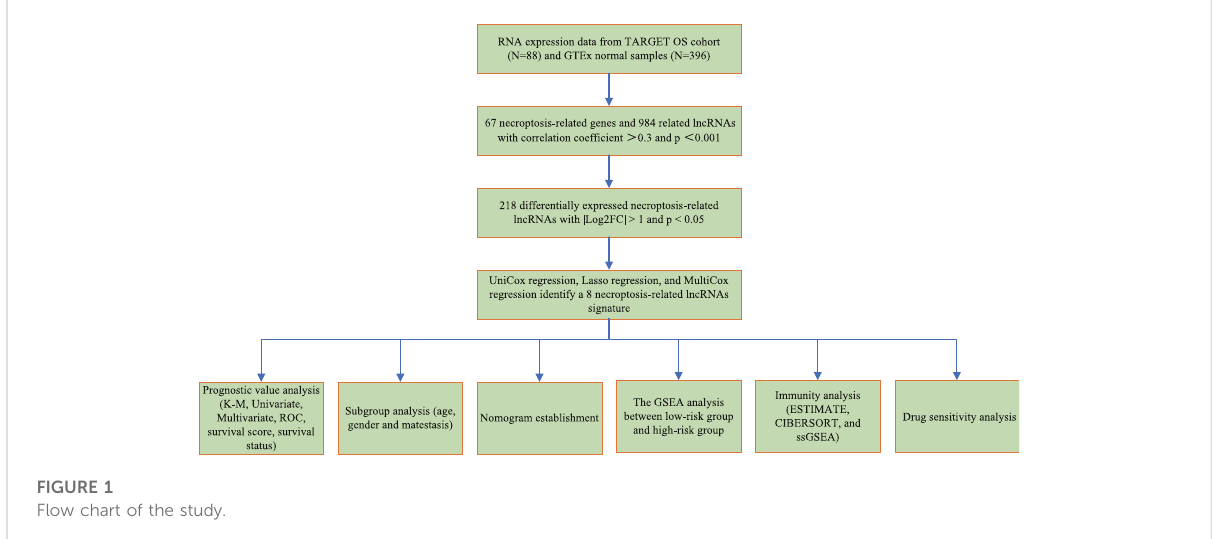
FIGURE 1 Flow chart of the